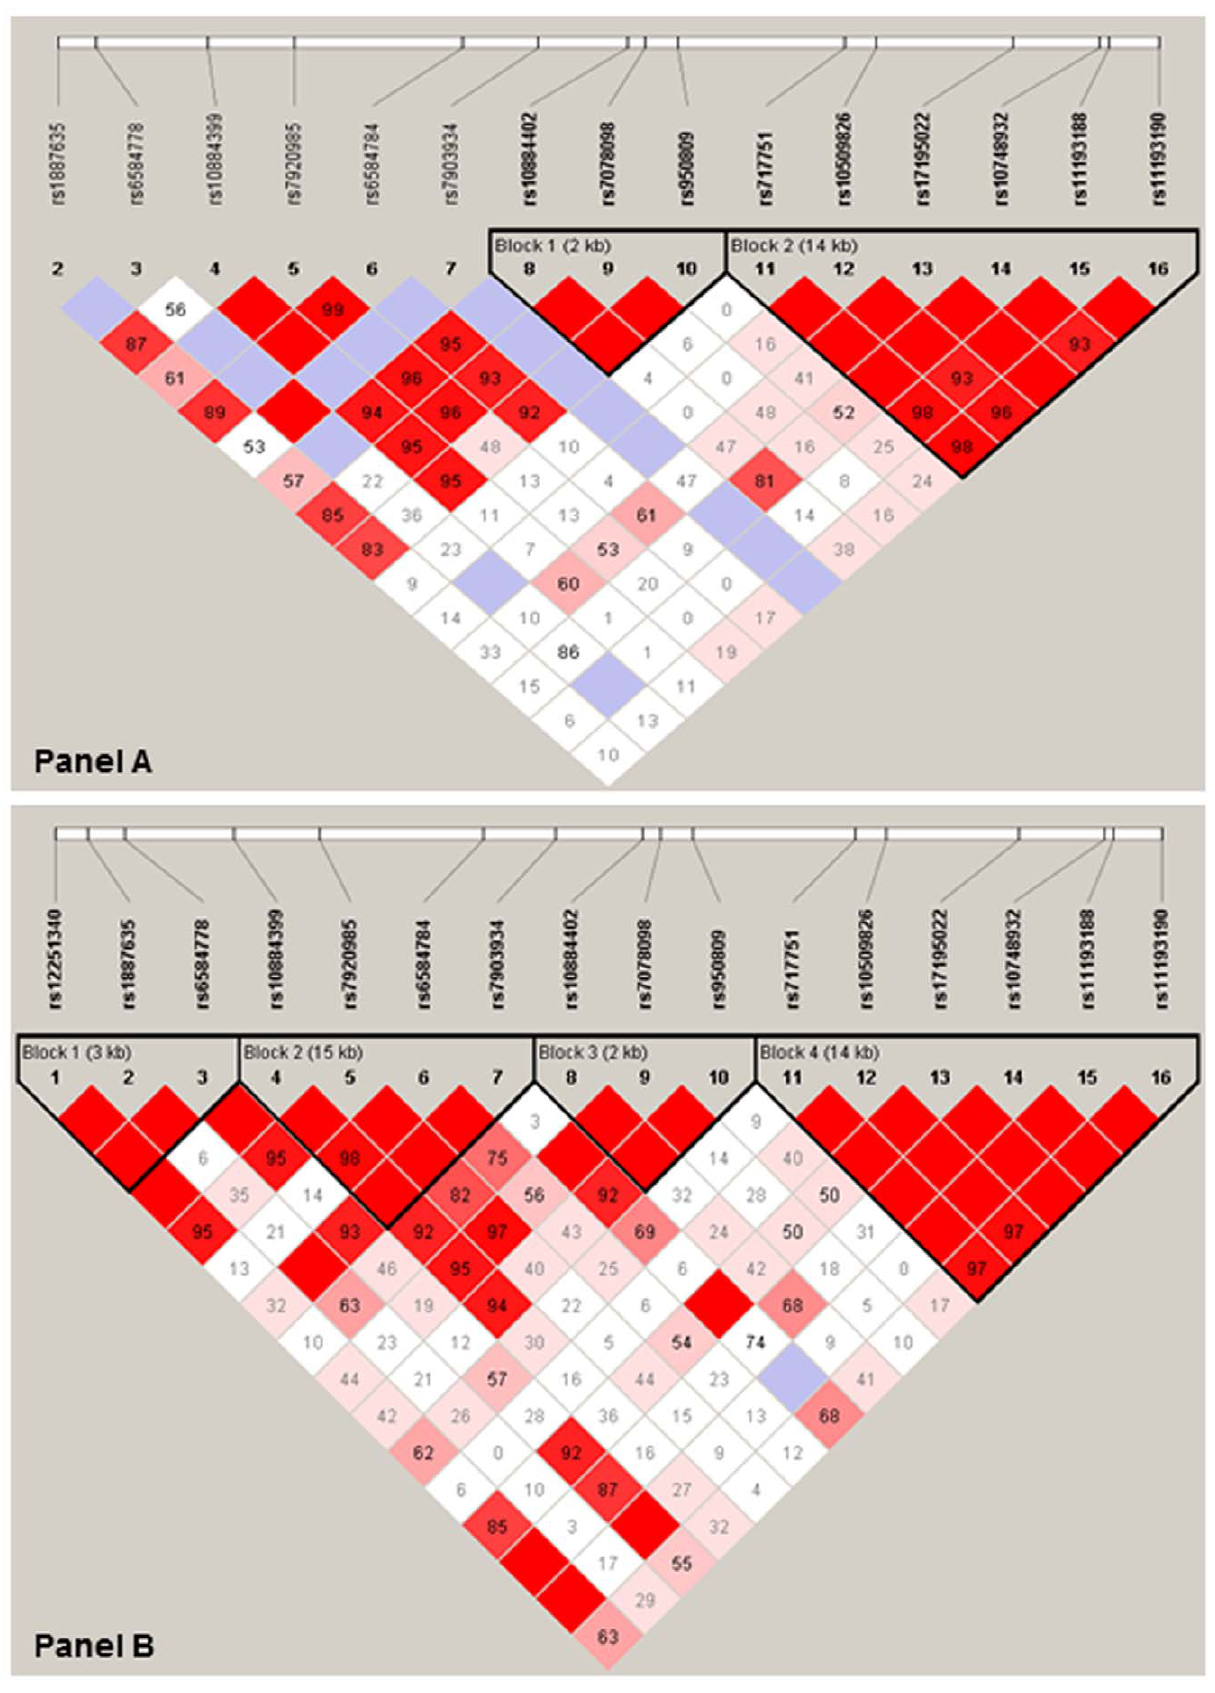
Figure 1. LD patterns of SNPs rs10884402, rs7078098 and rs950809. a) NIA-LOAD dataset (controls). b) Caribbean Hispanic dataset (controls). doi:10.1371/journal.pone.0024588.g001 PLoS ONE |